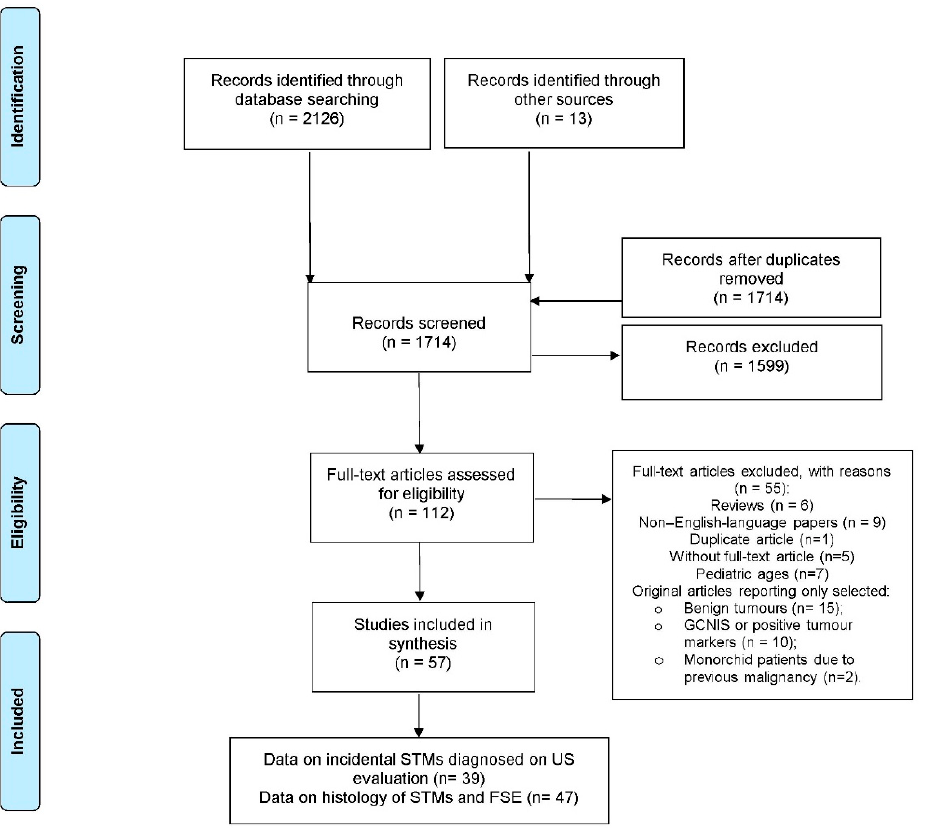
Figure 1. Flow diagram of evidence acquisition in a systematic review of studies addressing the prevalence and management of small testicular masses. GCNIS—germ cell neoplasia in situ; STMs—small testicular masses; US—ultrasound; FSE—frozen section examination.